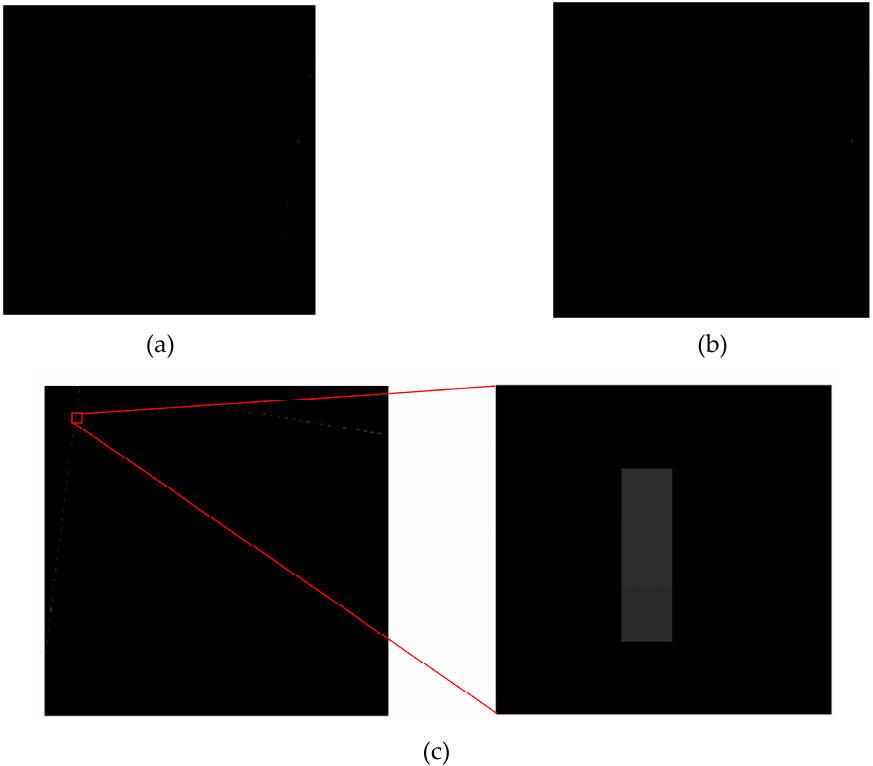
Figure 25. The differences between referenced image and other georeferenced images of the second image. ( a ) The differences between Ref-Img and Img-C++. ( b ) The differences between Ref-Img and Img-MATLAB. ( c ) The differences between Ref-Img and Img-ENVI.